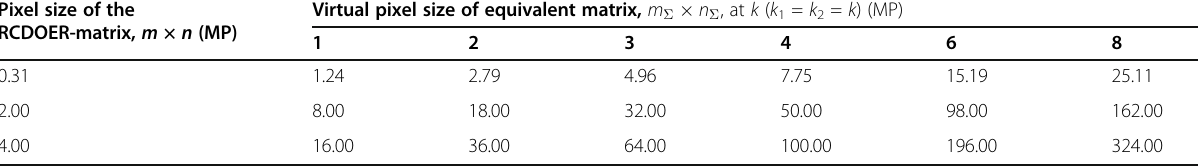
Table 1 Physical and virtual pixel size of RCDOER-matrix Pixel size of the RCDOER-matrix, m × n (MP)